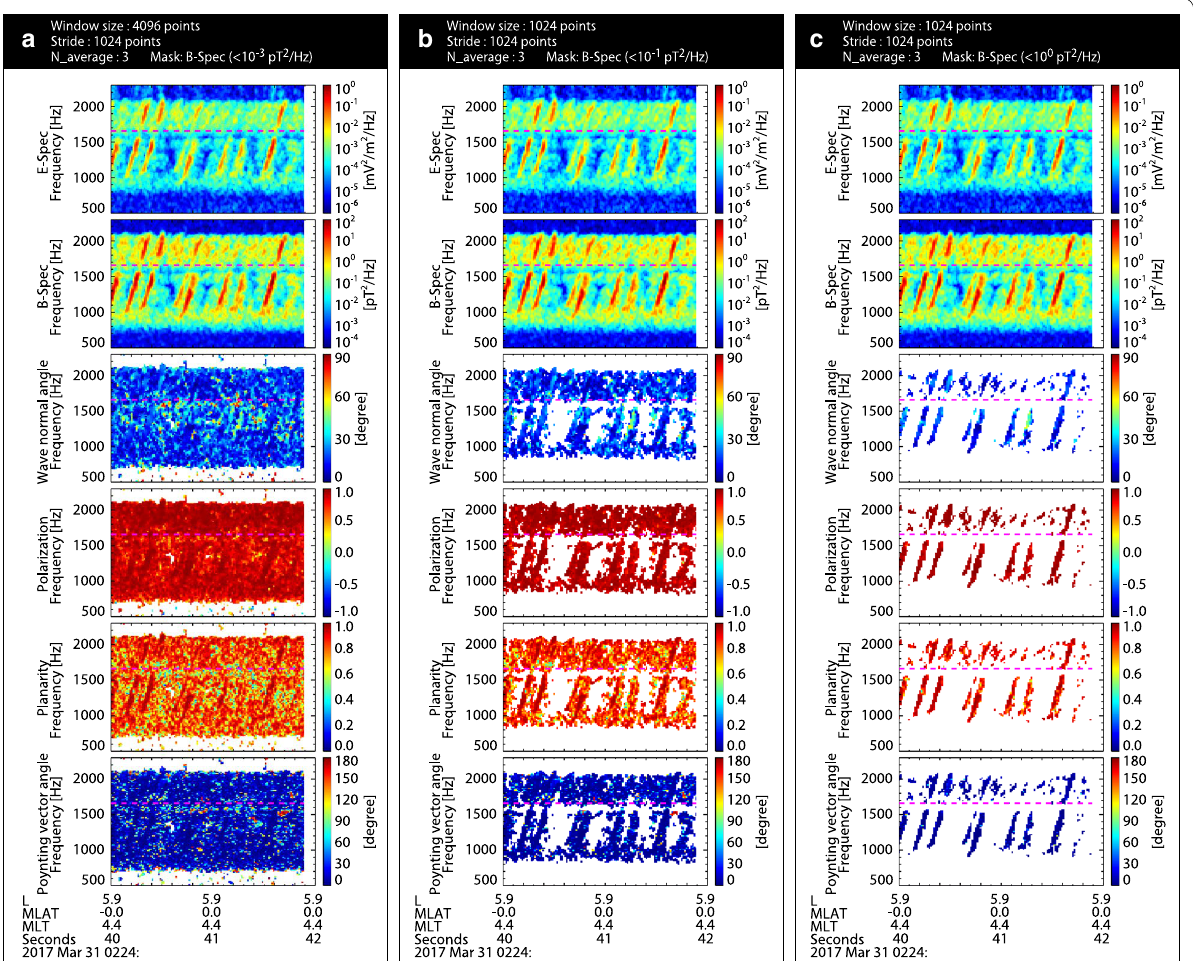
Fig. 7 Examples of results for three different masking thresholds of magnetic field spectral intensity. a Masked where the magnetic field spectral intensity was less than 10 − 3 pT 2 / Hz , b masked where magnetic field spectral intensity was less than 10 − 1 pT 2 / Hz and c masked where magnetic field spectral intensity was less than 10 0 pT 2 /